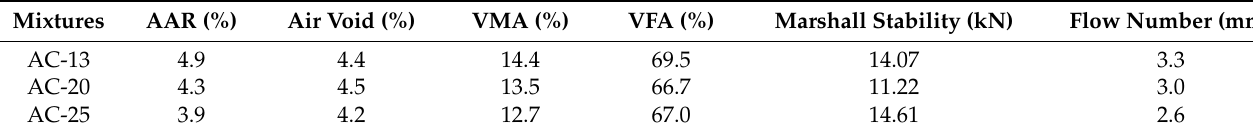
Figure 2. Slabs with the cylinder samples extracted from the corners. Table 5. The Marshall mix design parameters.